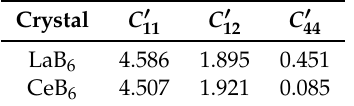
of the second-order elastic constants of LaB 6 and CeB 6 . ij